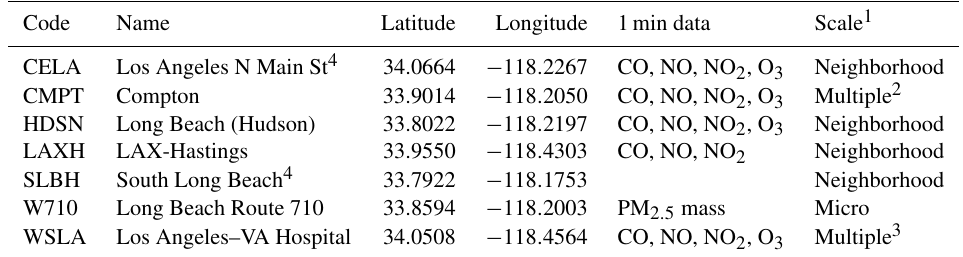
Table 4. Stationary monitoring sites in Los Angeles for which the SCAQMD provided high-resolution (1min) measurements. Hourly average gas and PM 2 . 5 mass concentrations are available for other locations through EPA public data archives.